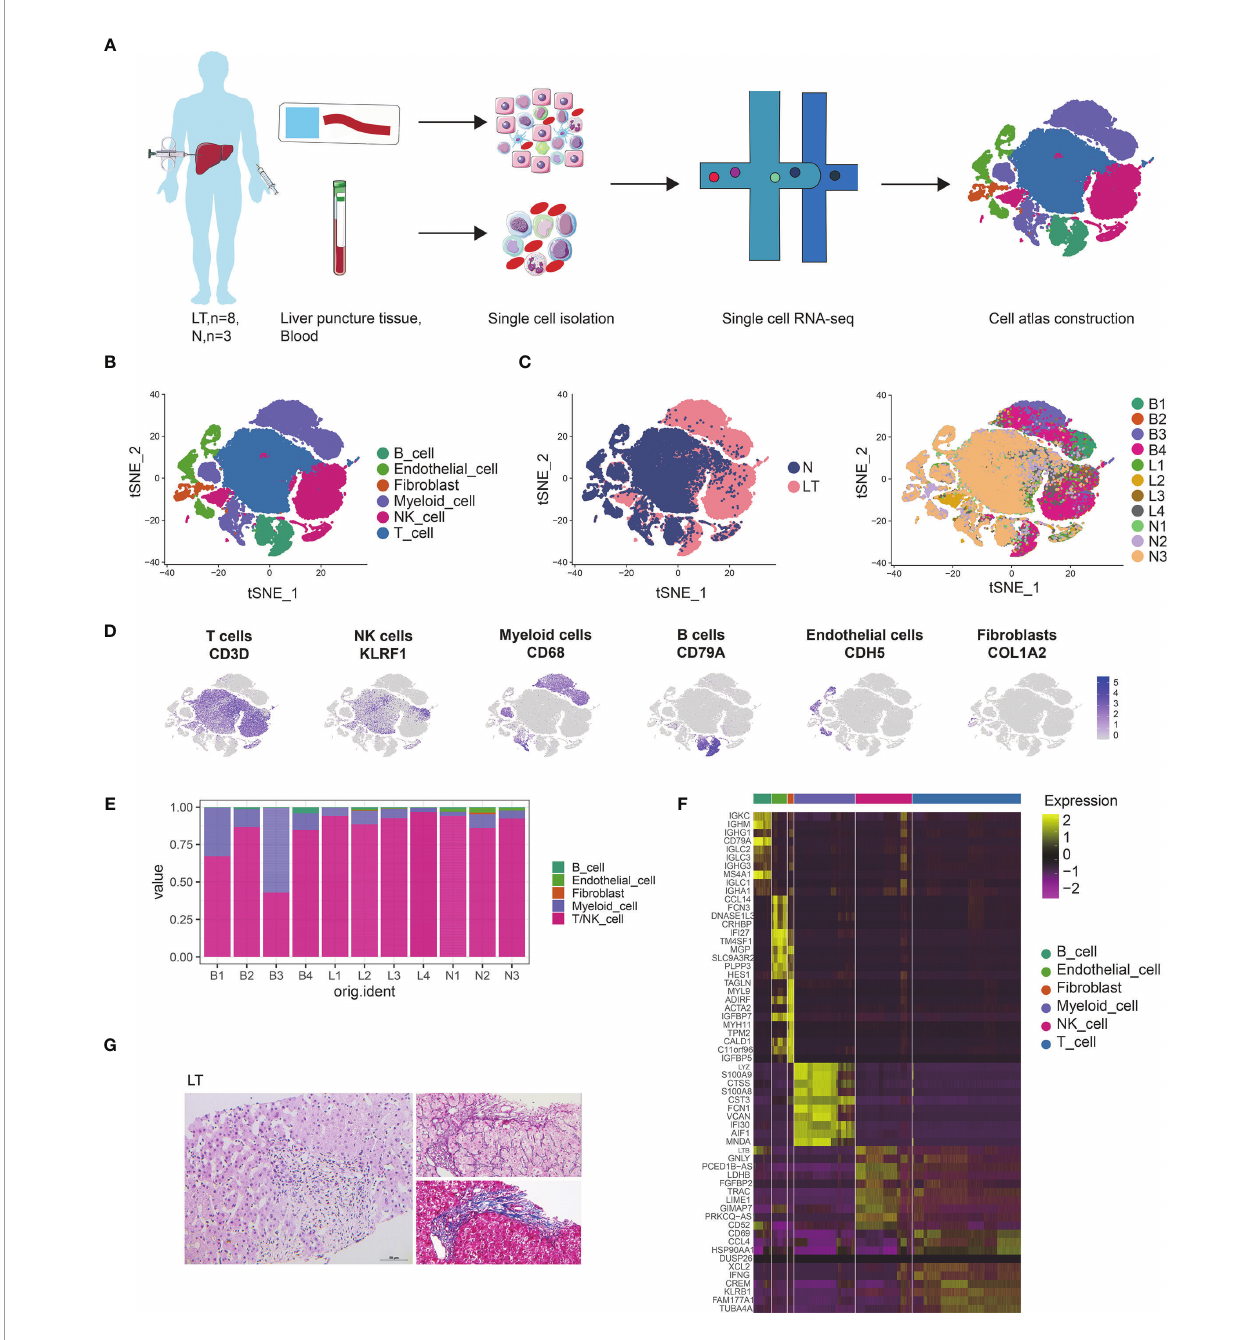
FIGURE 1 | Single cell atlas of human liver transplantation. (A) Schematic diagram of scRNA-seq analysis work fl ow. (B) tSNE plots for cell type identi fi cation of 68,174 high-quality cells. (C) tSNE plot colors by spatial distribution of cells in normal (N) and liver transplantation (LT) tissues. (D) Expression of canonical cell markers including CD3D, KLEF1, CD68, CD79A, CDH5, and COL1A2. (E) Barplots showing the proportion of cell types in each sample. (F) Heatmap showing the top 10 genes of each cell type. (G) HE, Masson, and reticular staining of liver transplantation